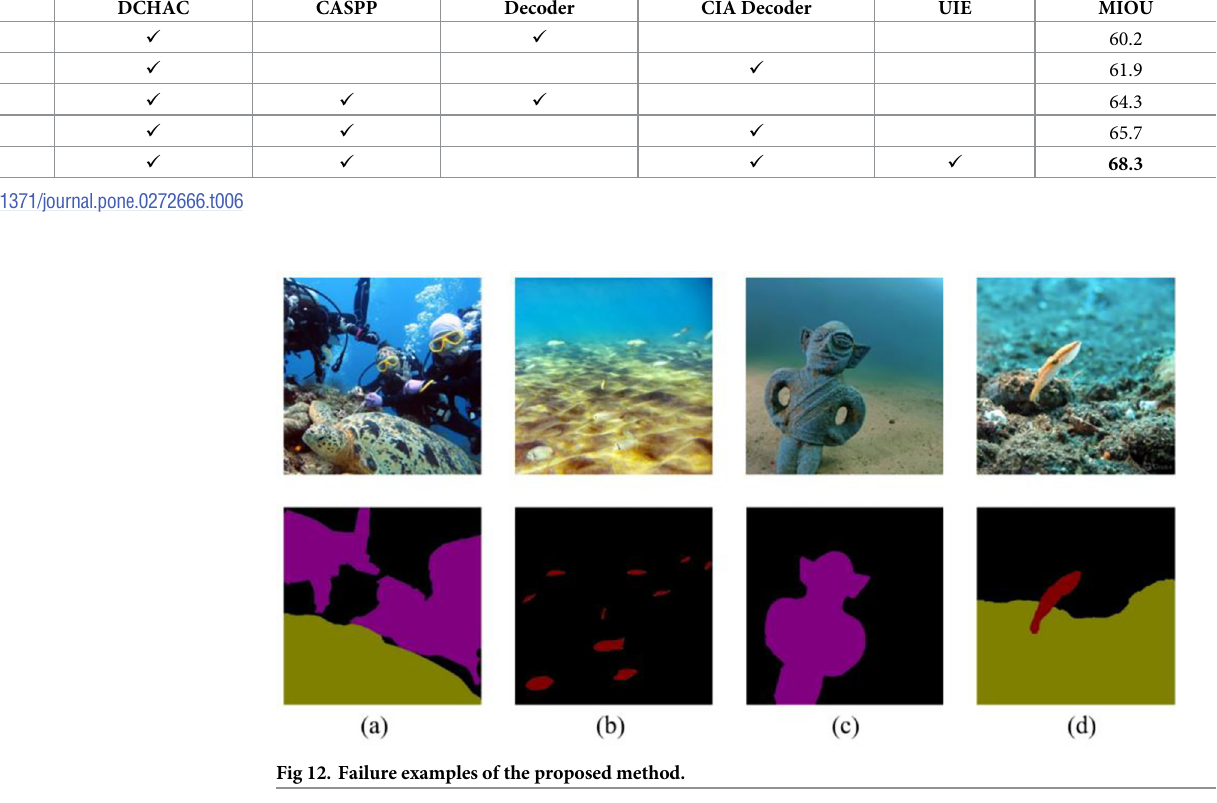
Table 6. The contribution of adding DCHAC, ACSPP, CIA decoder, and UIE to the objective evaluation performance. The best results are marked in bold. Baseline